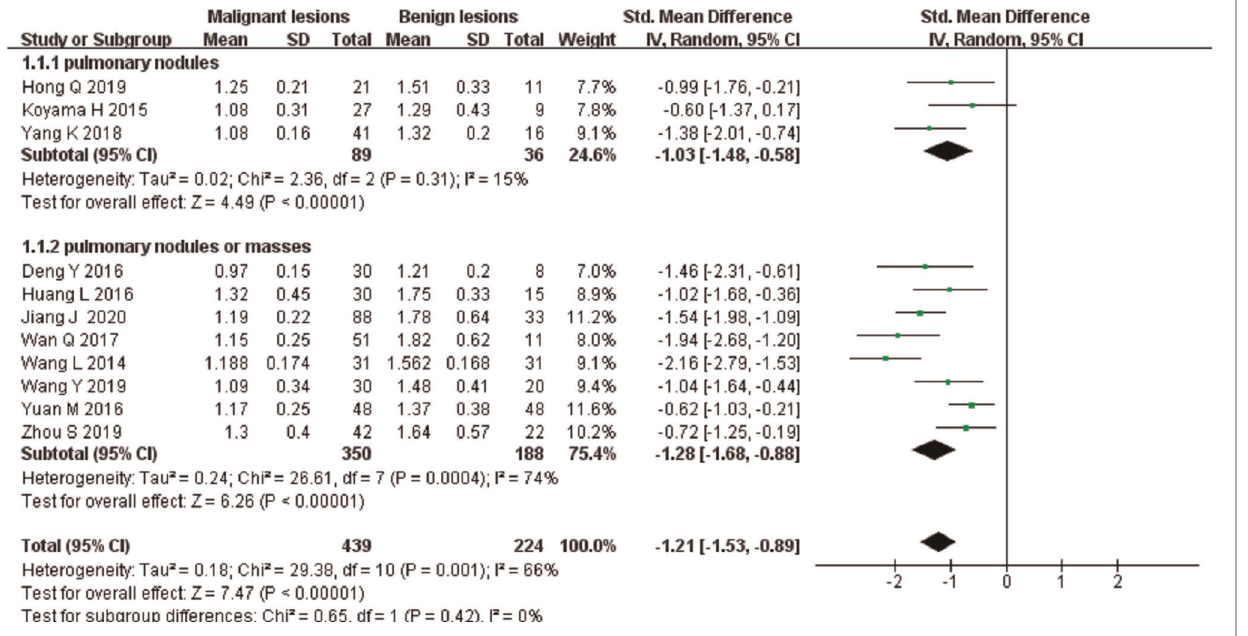
FIGURE 4 | Forest plot of the mean value of the apparent diffusion coef fi cient (ADC) between malignant and benign pulmonary nodules and masses.